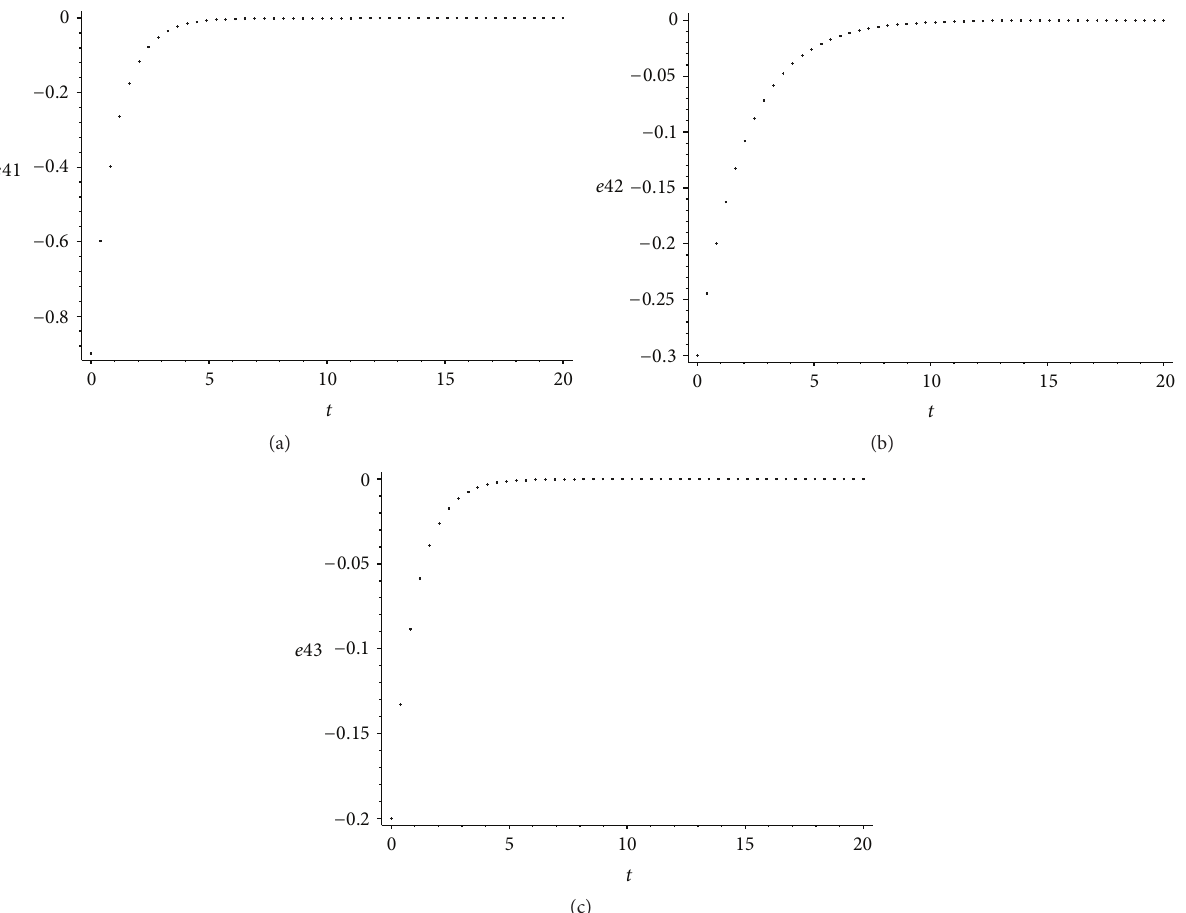
Figure 6: Network synchronization errors between node 3 and node